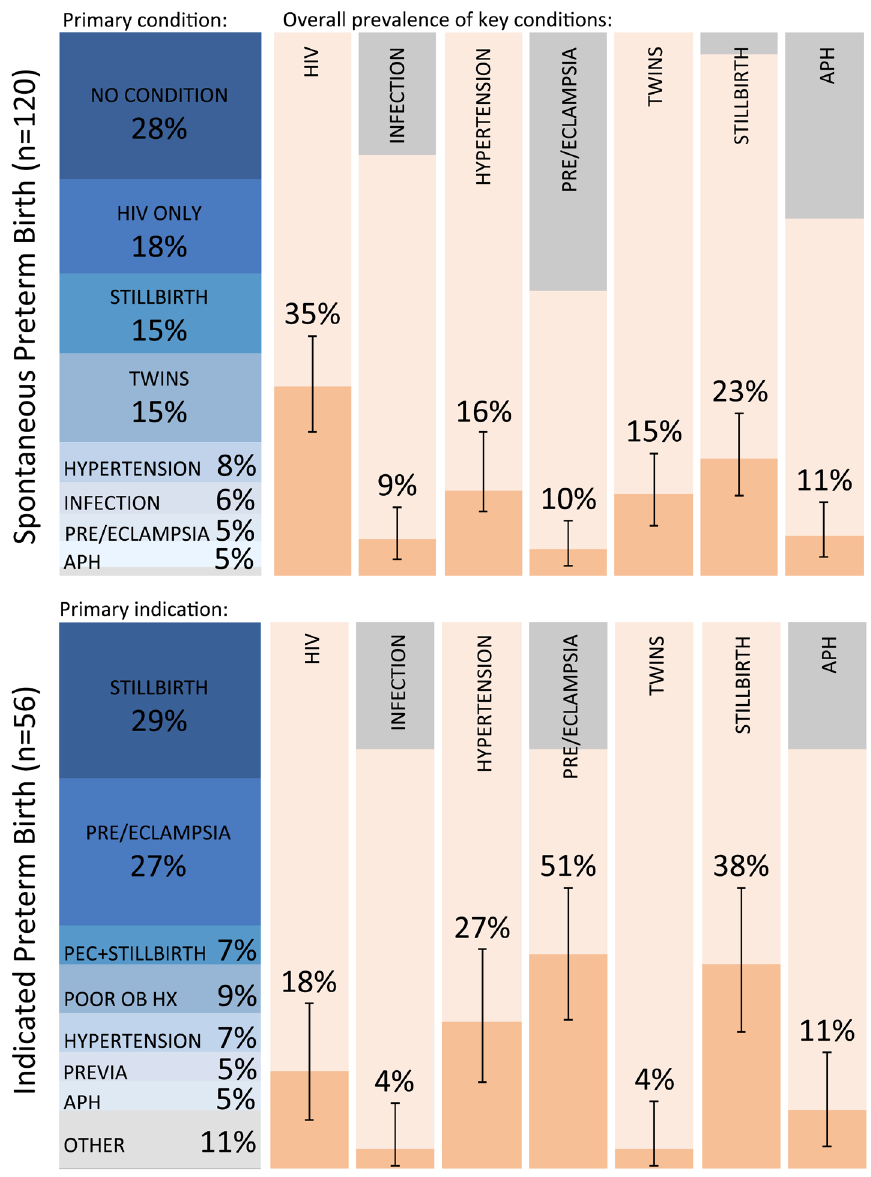
Figure 3. Parturition phenotypes among ZAPPS participants with preterm delivery. Of participants who underwent preterm delivery (n=181) in the ZAPPS cohort, 120 of them were spontaneous and 56 were indicated. This figure presents the frequencies of primary conditions present in spontaneous preterm deliveries, primary indications for indicated preterm deliveries, and the overall frequency with 95% confidence intervals of key conditions in each group. Gray bars represent missing values. APH, antepartum hemorrhage; OB HX, obstetrical history.